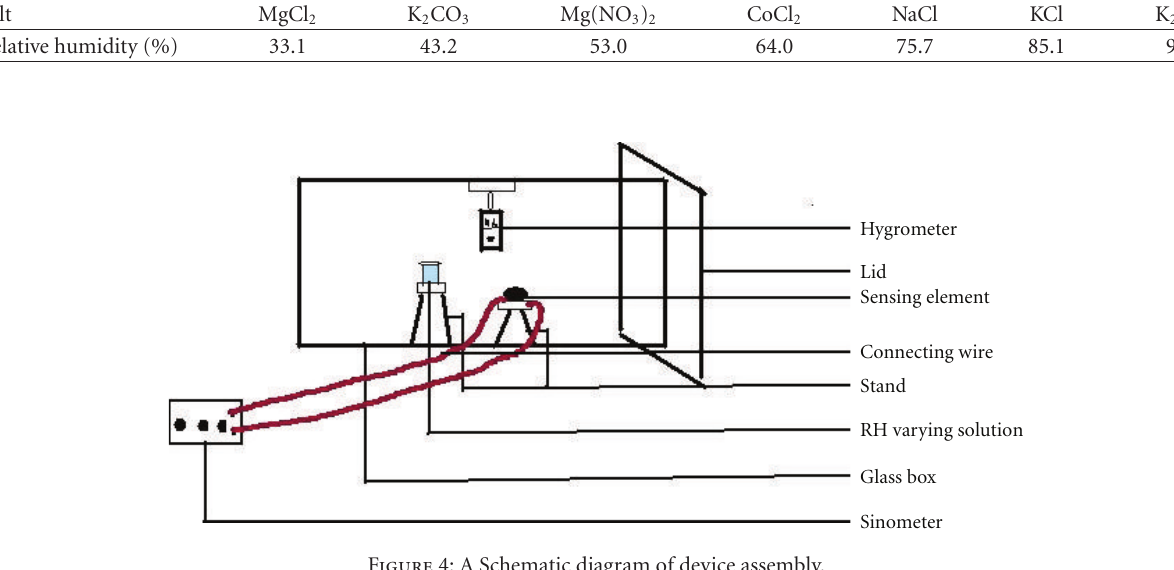
Figure 4: A Schematic diagram of device assembly.